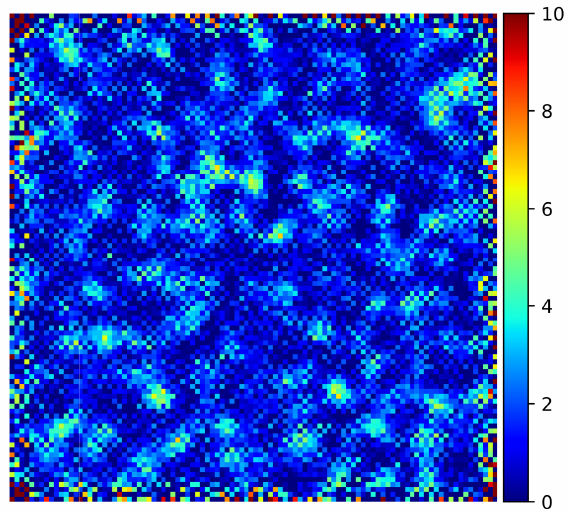
Figure 3. An illustrative example of the reconstructed images. created via Equations (10), (11), and (12). Different values of λ and ¨ σ are applied to reproduce different signal-to-noise ratios.